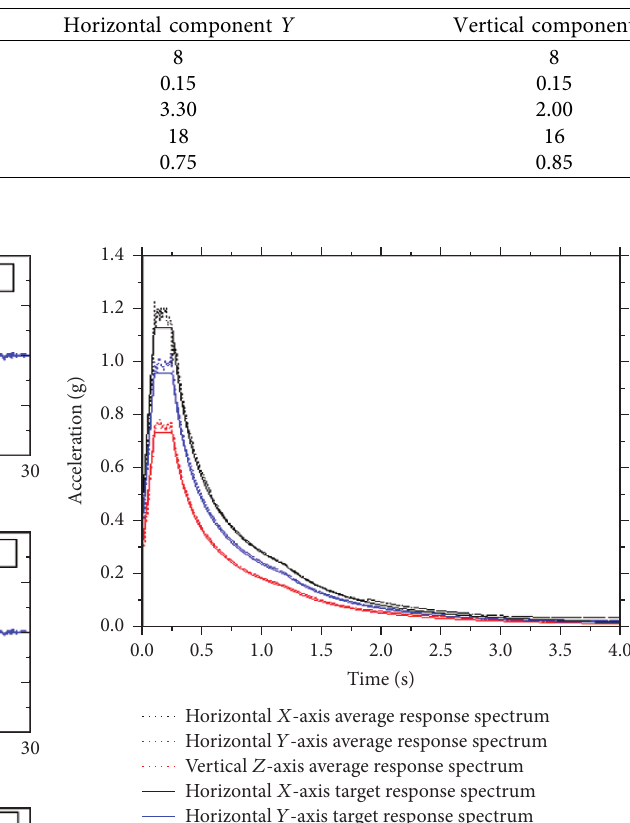
Table 1: The parameter value of the power spectrum